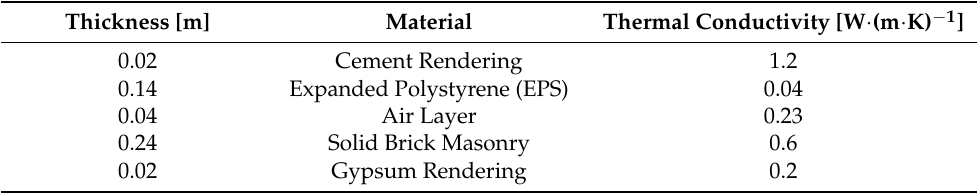
Table 1. Materials, layer thicknesses and thermal conductivities of the wall materials.